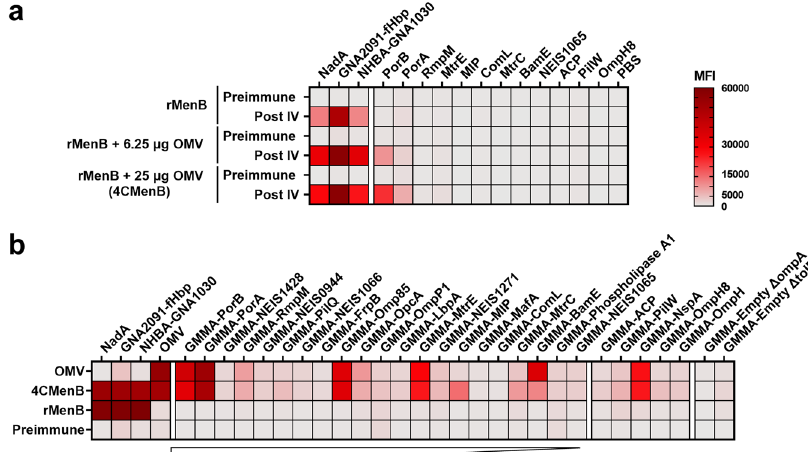
Fig. 2 The immunosignature of human and mouse antisera revealed the immunodominant OMPs of OMV. a Infant sera collected before and after the fourth dose of different vaccines were assayed as pool on a microarray containing exclusively recombinant proteins. b Pre- and post-immunization mouse sera were pooled (preimmune pool n = 80, rMenB pool n = 10, 4CMenB pool n = 54, OMV pool n = 88) and probed onto a microarray spotted with engineered E. coli GMMA. Samples are ranked according to the relative abundance of antigens in OMV 25 as shown by the triangle. Each tinted block represents the averaged reactivity of the replicated spots for each serum screened, and results are expressed as MFI values. Signals were considered positive when their MFI were greater than 5000, corresponding to the MFI of control protein spots after detection with fl uorescent-labeled secondary antibodies, plus ten times the standard deviation. Three arbitrary MFI thresholds were also assigned for low (5000 ≤ MFI < 15,000), medium (15,000 ≤ MFI < 30,000 MFI) and high (MFI ≥ 30,000) reactivities. Color scale of signal intensity is reported on the right of the